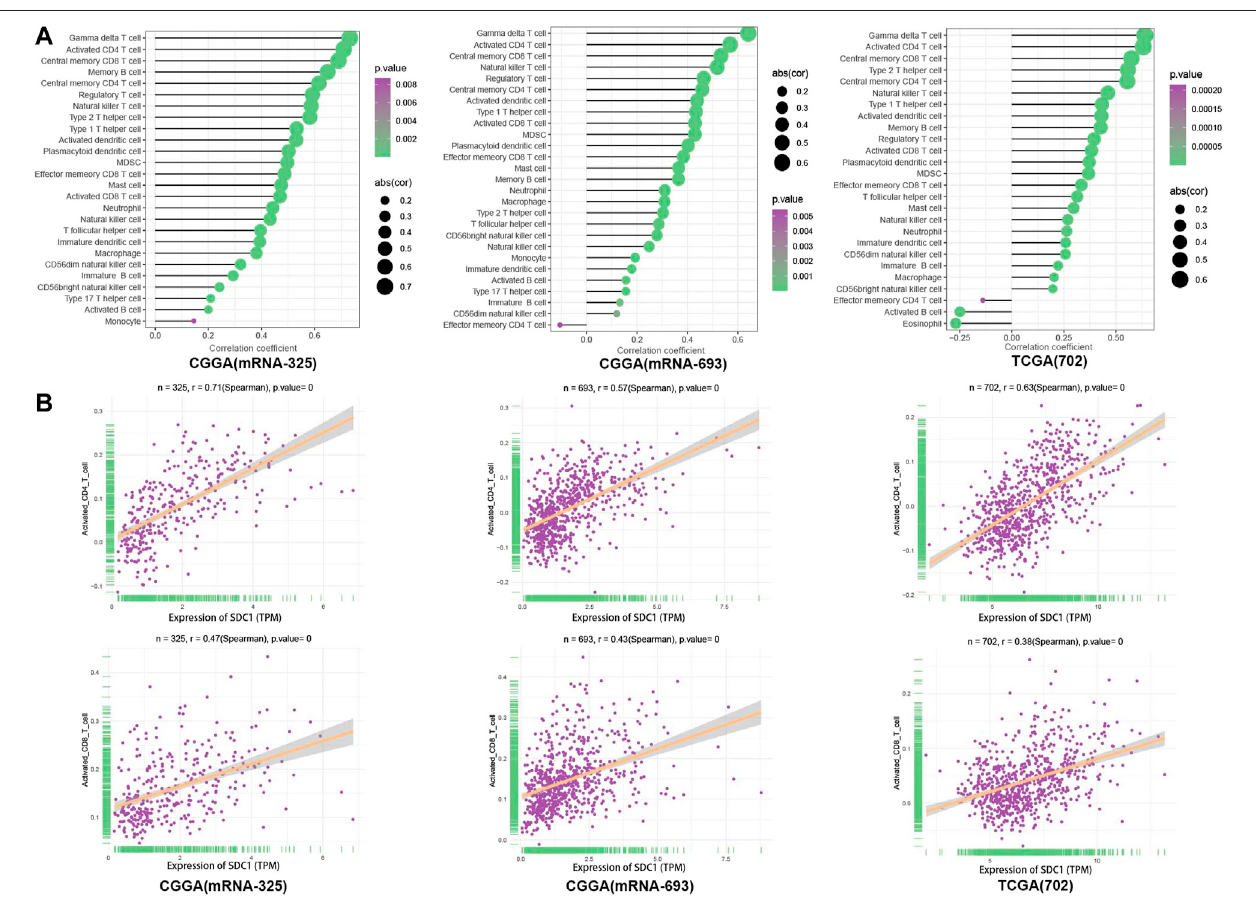
FIGURE 3 | The TICs were evaluated through GSVA with ssGSEA algorithms; (A) the expression data set representing the leucocyte gene signature matrix was used as a reference; the proportions of 28 tumor-in fi ltrating lymphocytes were assessed in glioma tissues. (B) The relationship between the immune cells and the expression of SDC1 in glioma samples was assessed using Spearman correlation